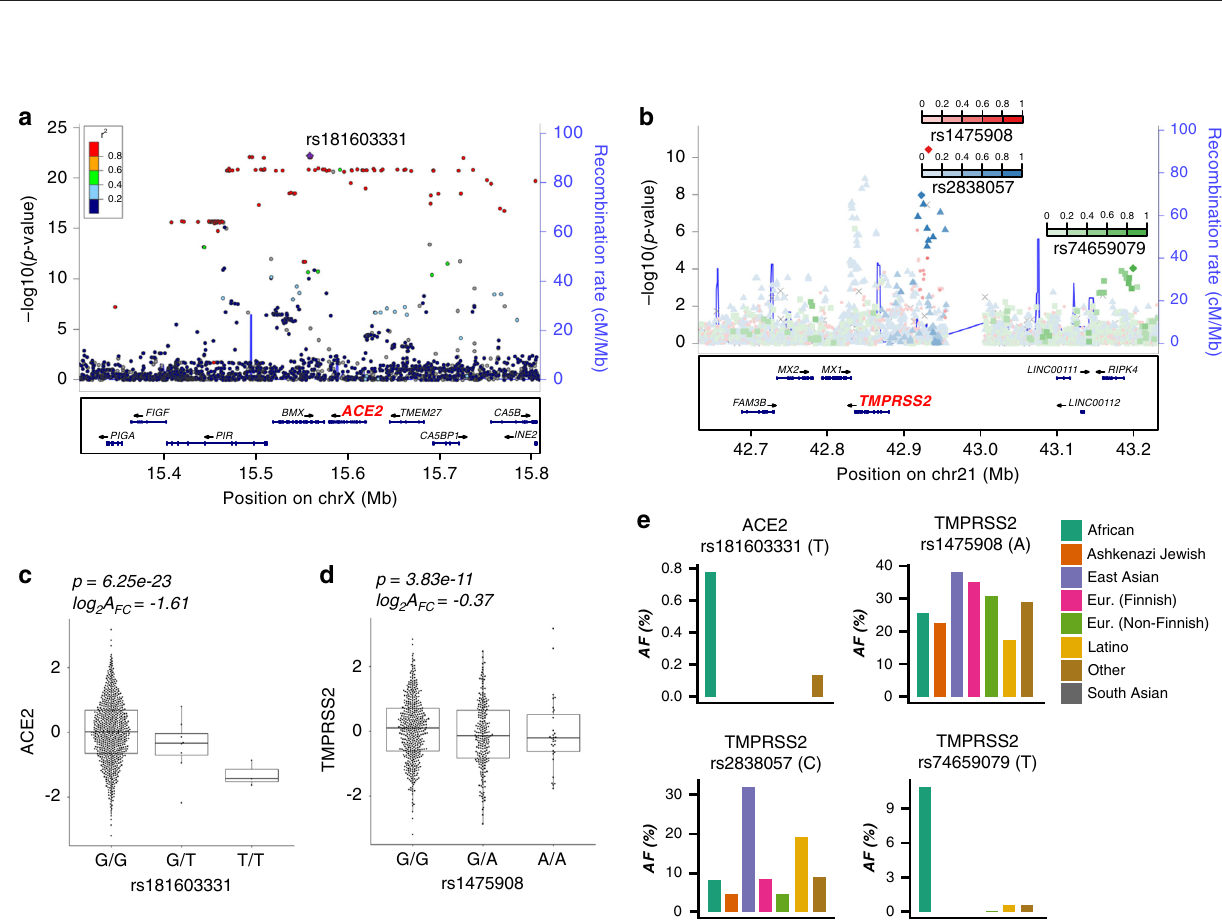
Fig. 6 Nasal airway ACE2 and TMPRSS2 are regulated by eQTL variants. a Locuszoom plot of ACE2 eQTL signals. The lead eQTL variant (rs181603331) is highlighted with a purple dot. The strength of linkage disequilibrium (LD) between rs181603331 and other variants is discretely divided into fi ve quantiles and mapped into fi ve colors (dark blue, sky blue, green, orange, and red) sequentially from low LD to high LD. b Locuszoom plot of TMPRSS2 eQTL signals. The three independent eQTL variants (rs1475908, rs2838057, rs74659079) and their LD with other variants ( r 2 ) are represented by red, blue, and green color gradient, respectively. c Box plots of normalized ACE2 expression among the three genotypes of the lead ACE2 eQTL variant (rs181603331). log 2 A FC = log 2 of the allelic fold change associated with the variant. ( n : GG = 654, GT = 8, TT = 3). eQTL p -values were obtained from testing the additive genotype effect on gene expression using the linear regression model implemented in FastQTL. Benjamini – Hochberg correction was used to control for false discovery rate. d Box plots of normalized TMPRSS2 expression among the three genotypes of the lead TMPRSS2 eQTL variant (rs1475908). log 2 A FC = log 2 of the allelic fold change associated with the variant. ( n : GG = 432, GA = 218, AA = 31). eQTL p-values were obtained from testing the additive genotype effect on gene expression using the linear regression model implemented in FastQTL. Benjamini – Hochberg correction was used to control for false discovery rate. e Bar plots depicting allele frequencies of the ACE2 eQTL variant rs181603331 and TMPRSS2 eQTL variants (rs1475908, rs2838057, rs74659079) across world populations. Allele frequency data were obtained from gnomAD v2.1.1. Box centers give the median, upper and lower box bounds correspond to fi rst and third quartiles, and the upper/lower whiskers extend from the upper/lower bounds up to/down from the largest/smallest value, no further than 1.5× IQR from the upper/lower bound (where IQR is the inter-quartile range). Data beyond the end of whiskers are plotted